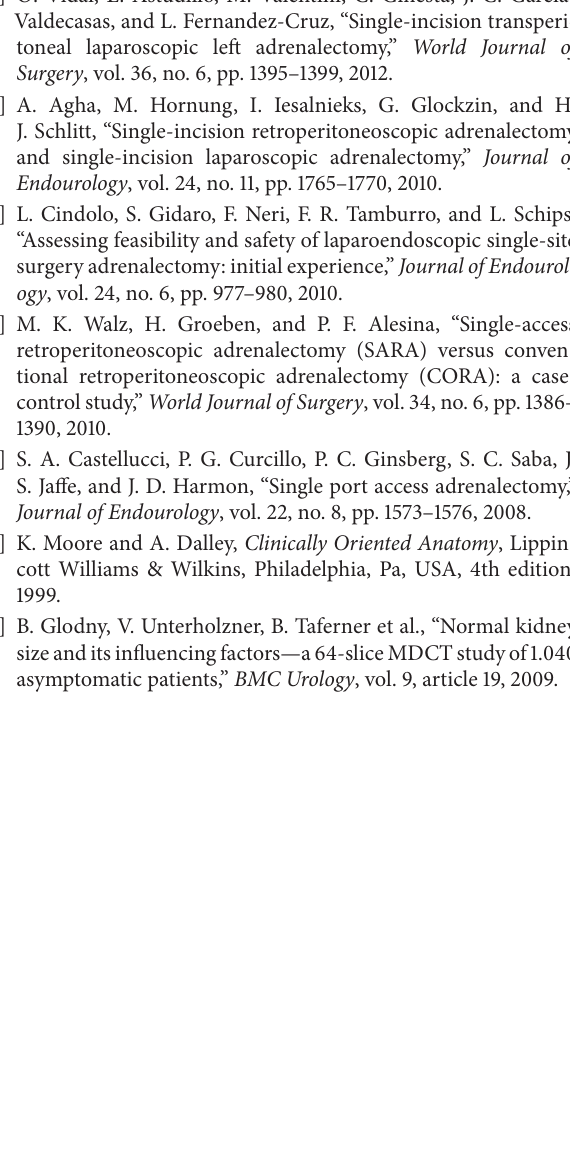
Figure 3: Postoperative scar of left-sided LAMP-TPA.